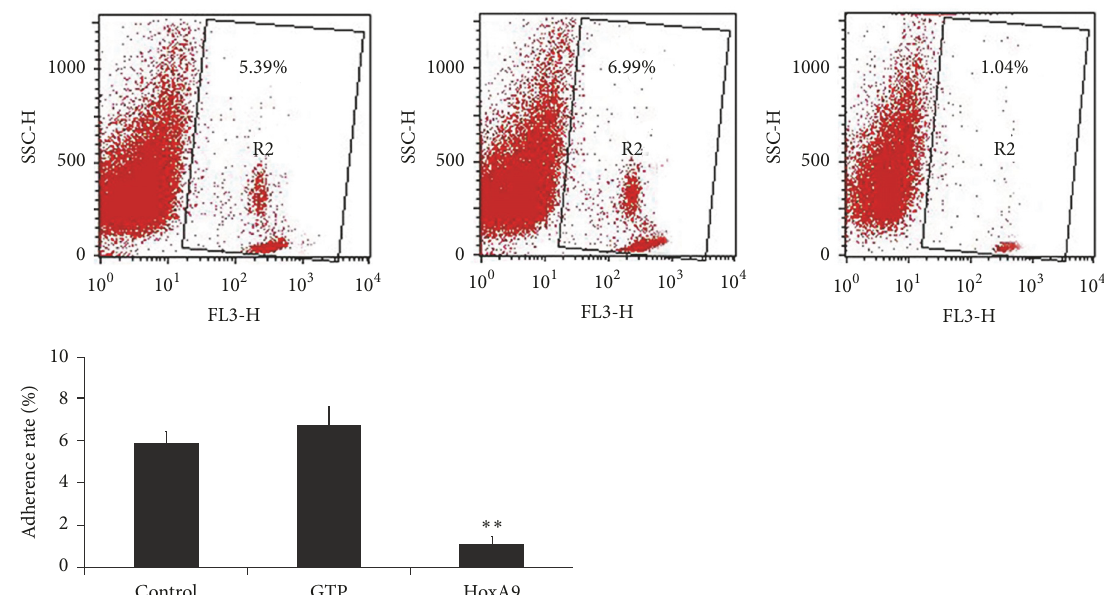
Figure 6: Adhesion of MSCs with leukocytes was determined by flow cytometry ( 𝑛 = 4 ). After infection with Hox A9, leukocyte adherence significantly decreased. ∗∗ 𝑃 < 0.01 versus control or